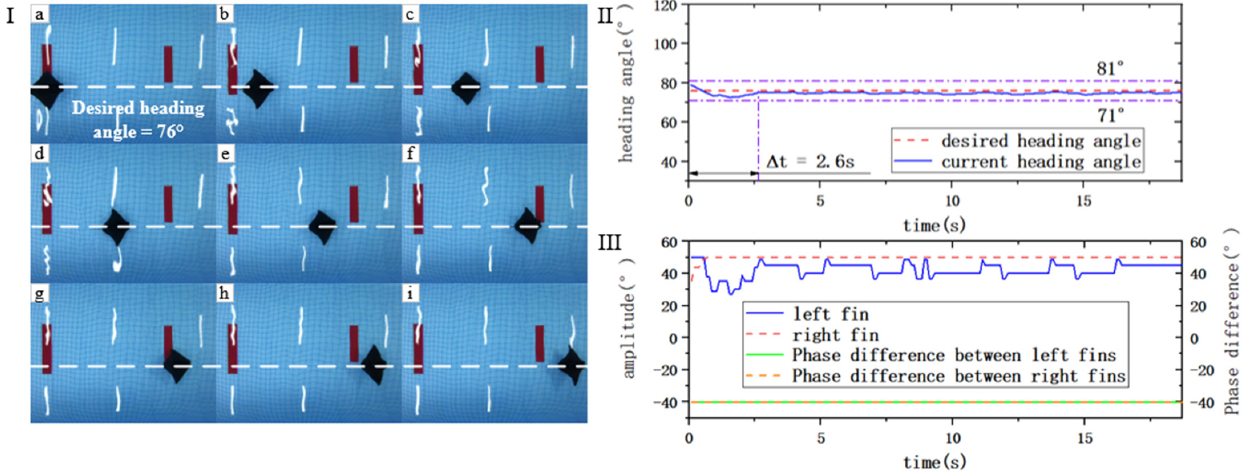
Figure 9. Frame diagram and data plot of the heading holding experiment. ( I ) Swimming frame diagram of the manta robot, where (a)–(i) represents the time order. ( II ) Heading angle data graph of the manta robot. ( III ) Data plot of pectoral fin motion parameters of the manta robot.